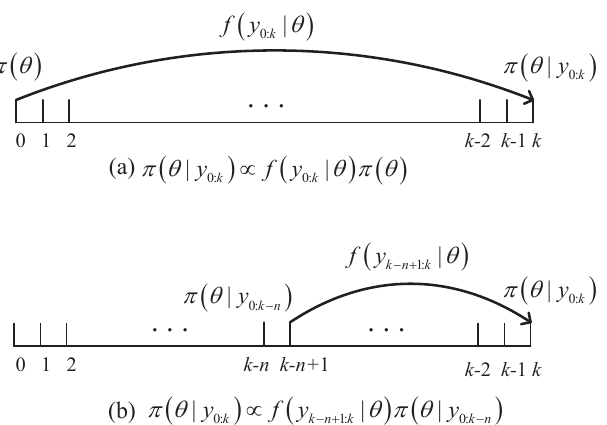
Figure 1. Schematic diagram of calculation of the posterior distribution π ( θ | y 0: k )